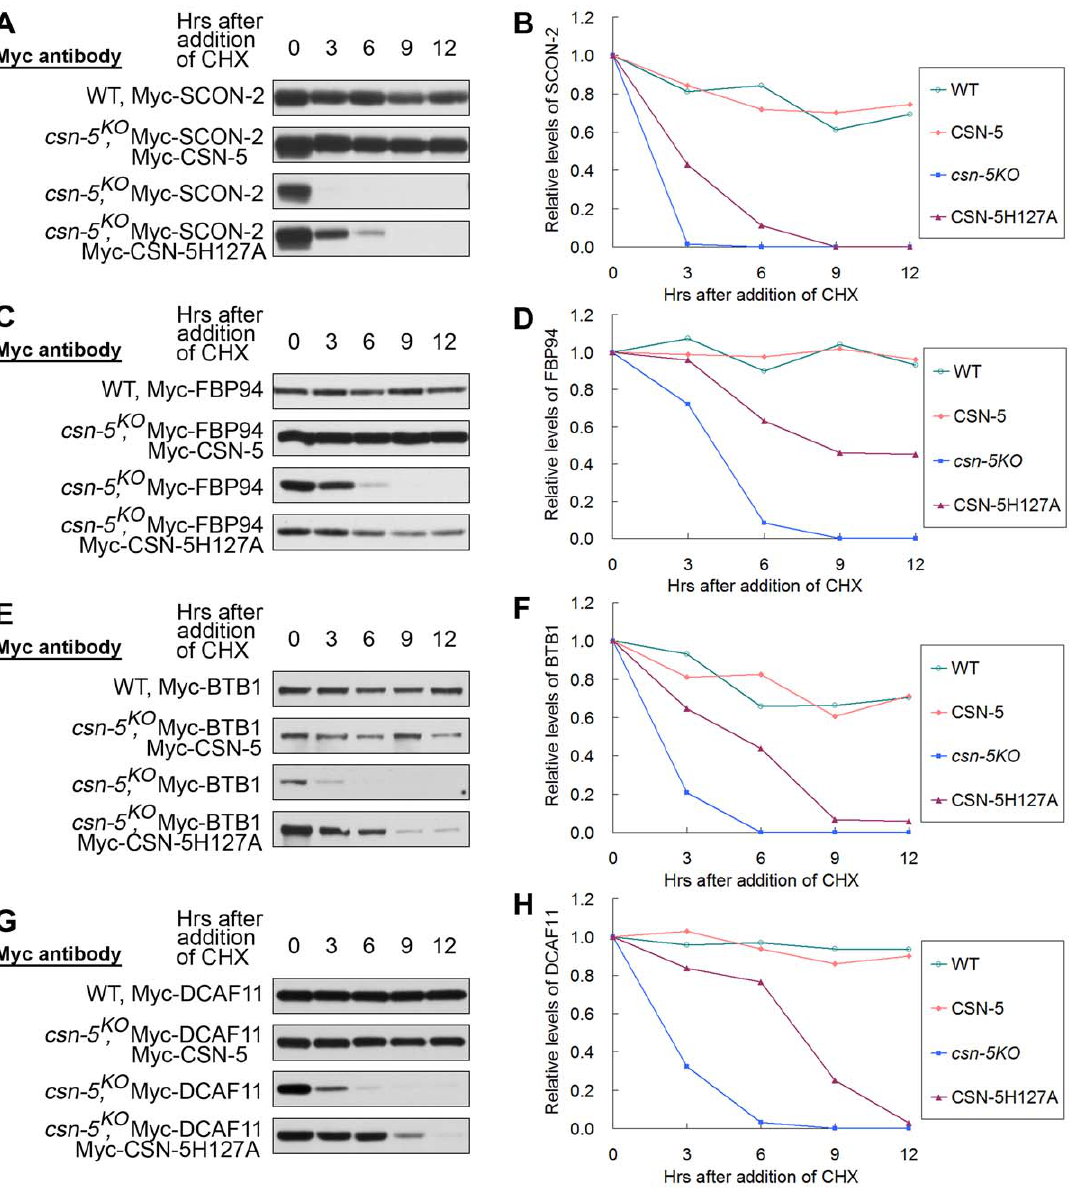
Figure 6. CSN containing mutant CSN-5 efficiently prevents degradation of substrate receptors of CRLs. Western blot analyses with labeled antibody showing degradation of Myc-SCON-2 (A), Myc-FBP94 (C), Myc-BTB1 (E), and Myc-DCAF11 (G) after addition of cycloheximide (10 mg/ mL) in the wild-type, csn-5 KO , csn-5 KO complementation with CSN-5 and CSN-5H127A strains. Densitometric analyses from four independent experiments showing the degradation of Myc-SCON-2 (B), Myc-FBP94 (D), Myc-BTB1 (F), and Myc-DCAF11 5 KO strains expressing CSN-5 proteins with different point mu- tations in the JAMM metal-binding motif, the deneddylation activity was disrupted, while the assembly of the CSN complex and interactions between CSN and cullin proteins were not af- fected. Therefore, this system has great potential as a model for distinguishing between the two activities of the CSN. A recent study suggests that neddylated Cul1 and Cul3 are unstable in D. melanogaster csn mutant cells due to a defect in CSN deneddylation activity, whereas unneddylated cullins are stable in csn-5 mutant cells [33]. The results presented here show that un- stable forms of Cul1 in the csn-5 mutant were partially restored by expression of mutant CSN-5 protein without deneddylation ac- tivity. Like the stability of unneddylated Cul1 and Cul3 in D.